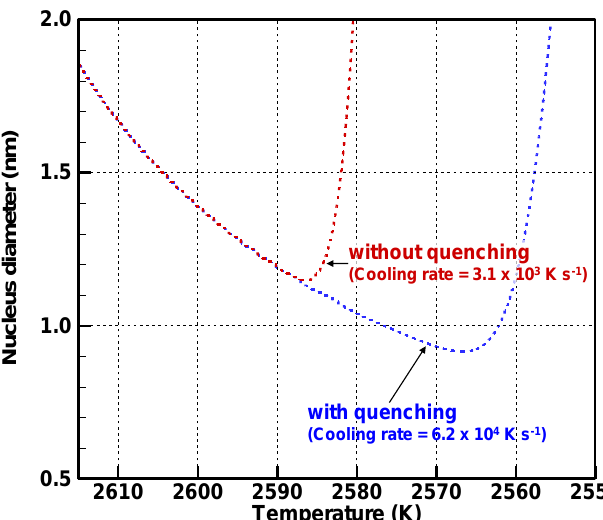
Figure 10. Evolutions of nucleus diameters.